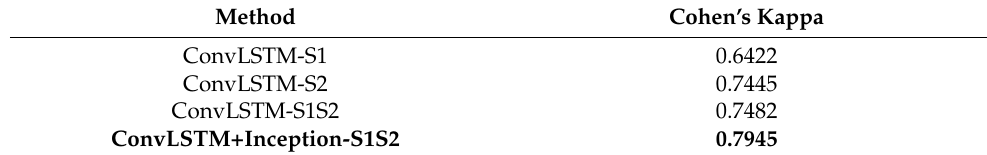
Table 8. Cohen’s Kappa for each method for 10 semantic classes (In bold the best